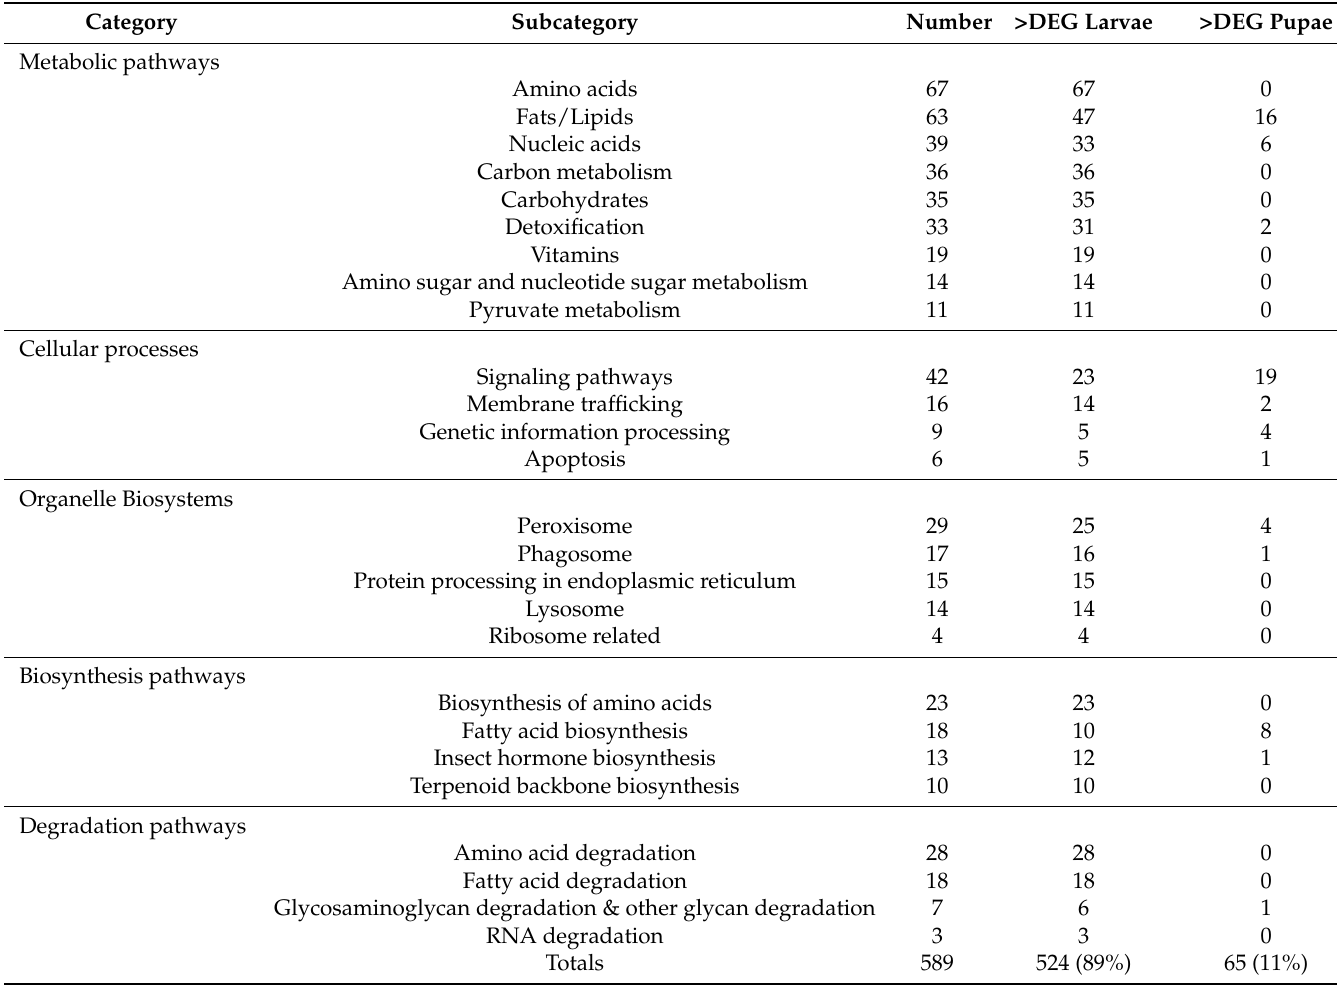
Table 3. Overview of pathways represented by >4-fold differentially expressed genes (DEG) found in larva and pupa Solenopsis invicta samples. Details provided in Table